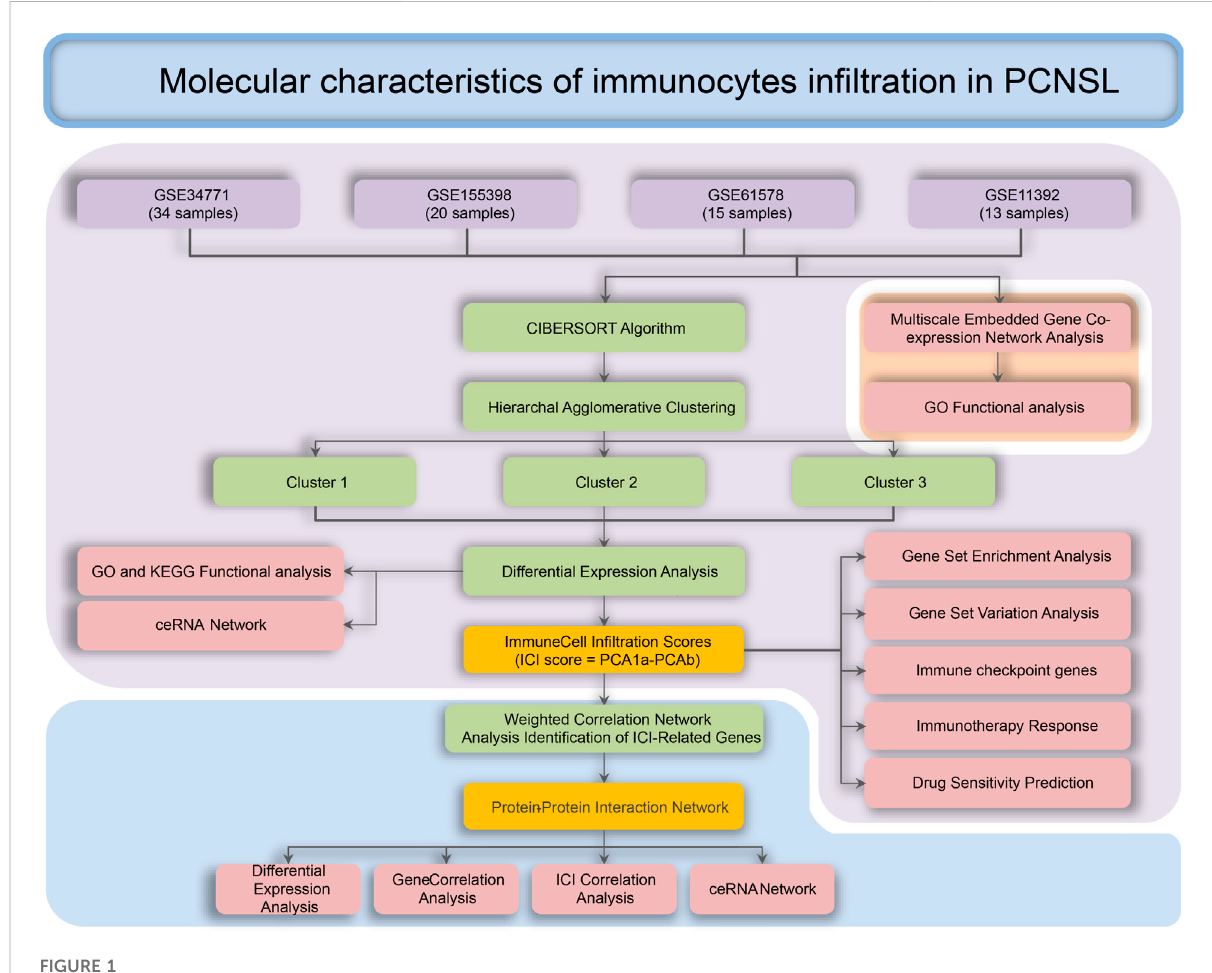
FIGURE 1 Process for the analysis of the molecular characteristics of immune in fi ltrating cells in patients with